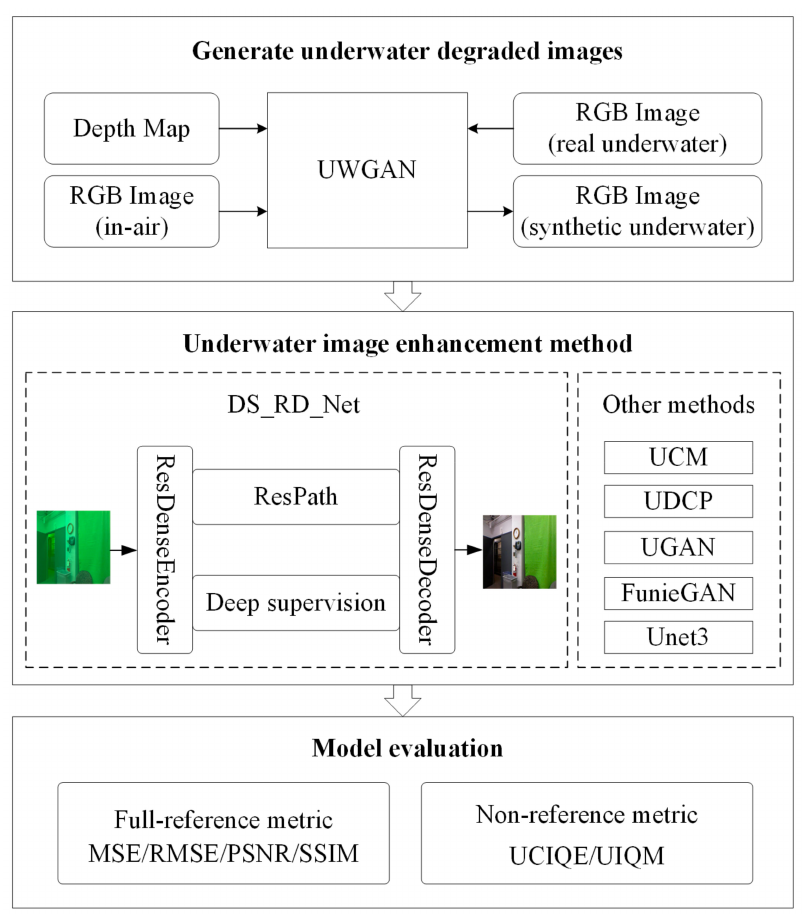
Figure 1. The proposed general framework for underwater image enhancement (three major parts: synthetic model of underwater images based on UWGAN, underwater image enhancement network based on DS_RD_Net, and evaluation of underwater image enhancement